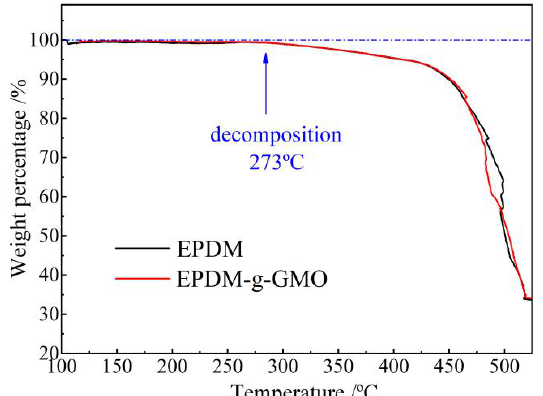
Figure 5. TGA profiles of weight loss versus temperature for the crosslinked EPDM and EPDM-g- GMO materials.